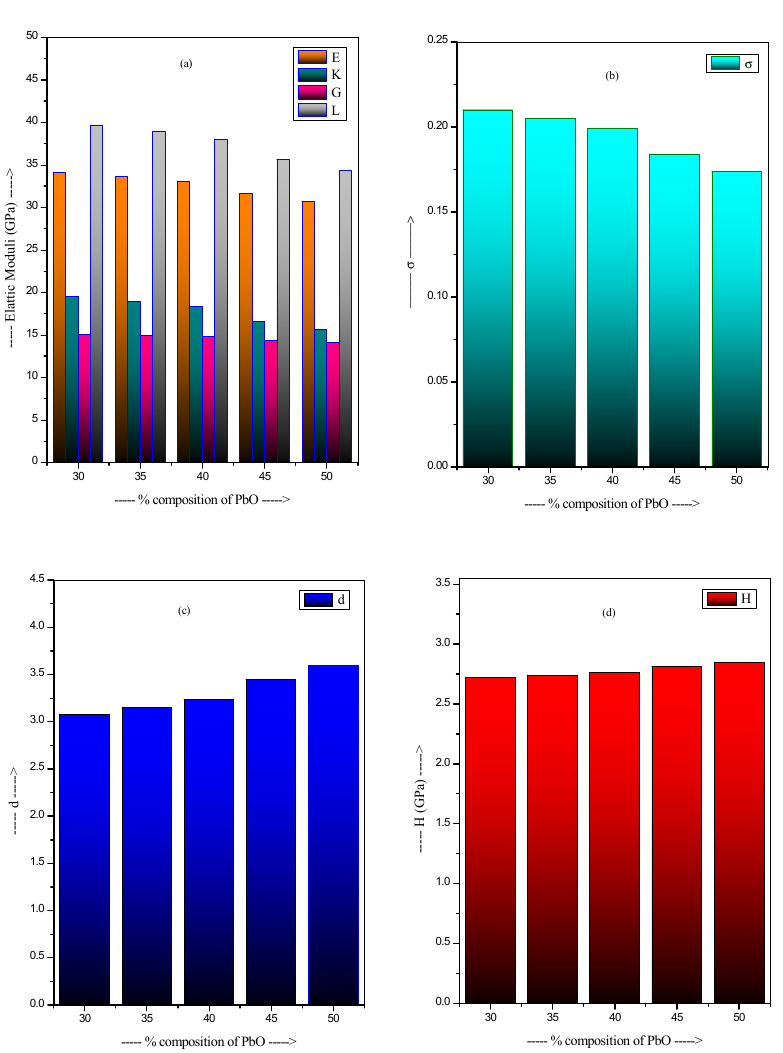
Figure 1. The variation of mechanical properties with the concentration of PbO. ( a ) elastic moduli ( b ) σ ( c ) d ( d ) H μ ρ(cid:3415) values of Figure 2 shows the influence of the photon energy on the computed μ ρ(cid:3415) as energy the studied glasses. The figure shows a consistent decay in the value of progresses with the decay appearing to be swift for energies below 88 keV compared to μ ρ(cid:3415) indicates relative reduction in the rest of the energy spectrum. Such smooth decay in the photon absorbing capacity of the glasses at higher energies. This is due to the reduc- tion in the photon interaction cross section of the glasses as energy increases. Within the